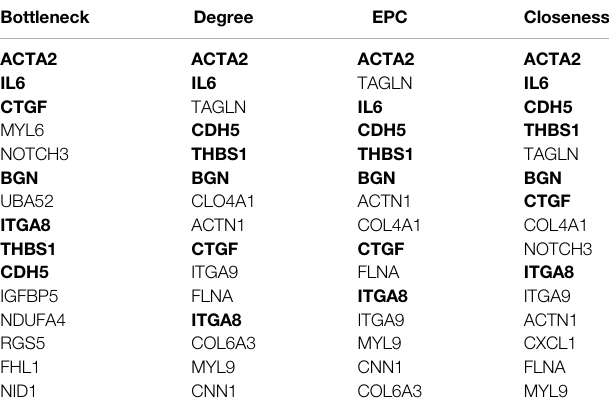
Bold characters represent the common genes screened by the four